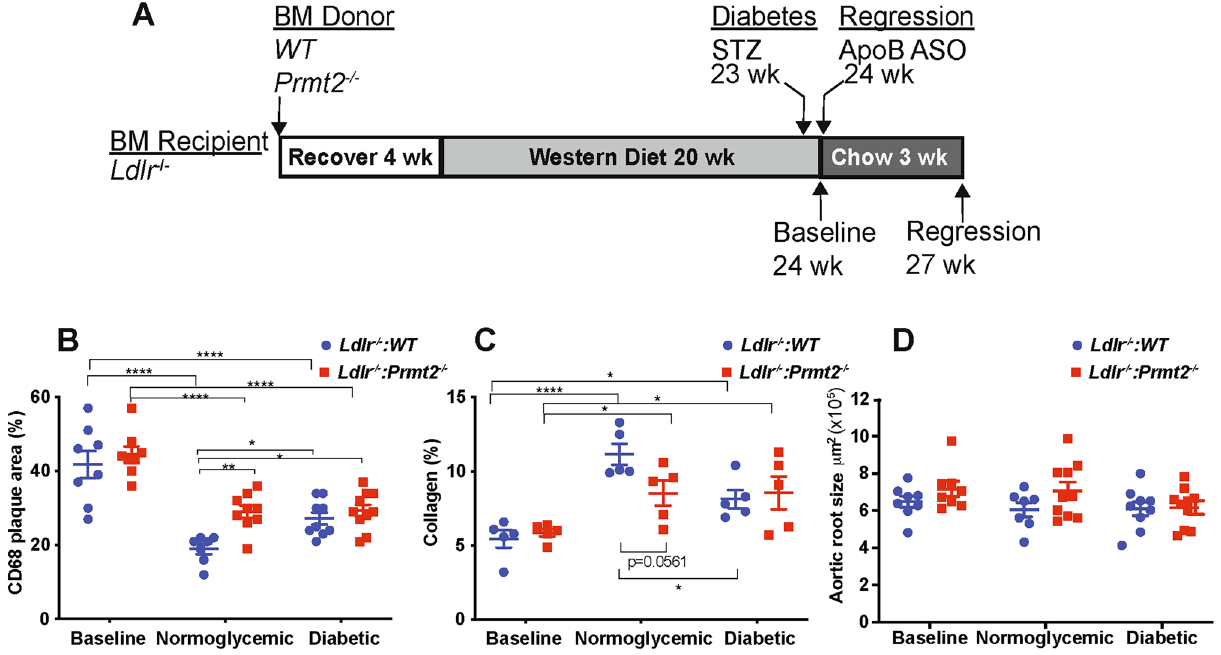
Figure 1. Myeloid PRMT2 deficient mice have increased CD68+ cells and decreased collagen content in nondiabetic conditions after plasma lipid reduction. ( A ) Experimental design: Bone marrow (BM) from WT and Prmt2 −/− donor mice was transplanted into Ldlr −/− recipient mice. After 4 weeks of recovery, the mice were placed on a Western diet (WD) for 20 weeks. A set of animals at 20 weeks of WD feeding was used as the baseline group. Two other groups of animals received citrate buffer or STZ at 23 weeks. At 24 weeks, to lower lipids and promote regression, mice received apoB-ASO injections, switched to a chow diet for 3 weeks, and were used as the regression groups. ( B ) Aortic roots from baseline and the four regression groups were sectioned and stained for CD68+ cells. Data are shown as the percentage of plaque area. ( C ) Collagen content was determined by picrosirius red staining using both bright field and polarized light microscopy and quantified by Image-Pro Plus software. Data are presented as the percentage of lesion area. ( D ) Total plaque areas were quantified by Image-Pro Plus software. Each group contained 8–10 animals. Data (means ± SEM) were analyzed using one-way ANOVA followed by Bonferroni’s multiple comparison test. P values are shown as * P < 0.05 and **** P <